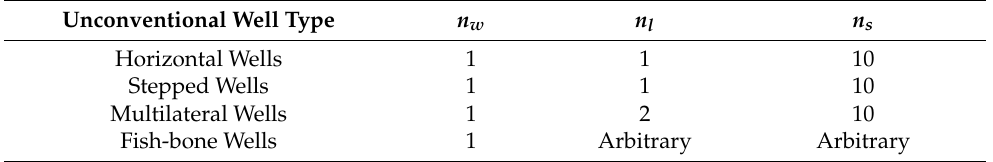
Table 1. The method of discretization for di ff erent unconventional wells.